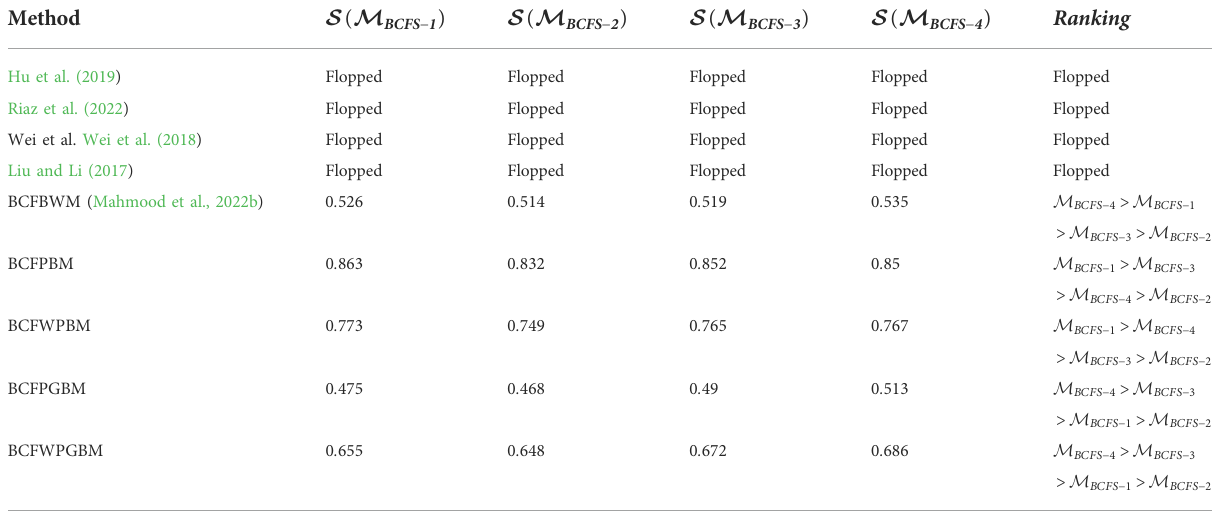
TABLE 4 SVs were determined by the method proposed in this study and from previous